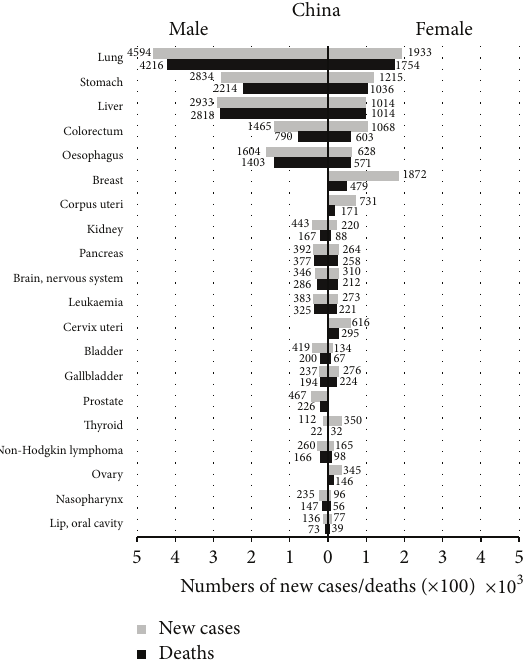
Figure 1: Twenty leading cancer types for the new cases and deaths by sex, China, 2012. GLOBOCAN 2012 (IARC) (13.7.2014) [2]. among populations in the countries far from the equator with insufficient UV solar radiation is relatively poor. Another possible reason for this difference is the level of economic development. The accuracy of diagnosis for PC is higher in more developed countries.